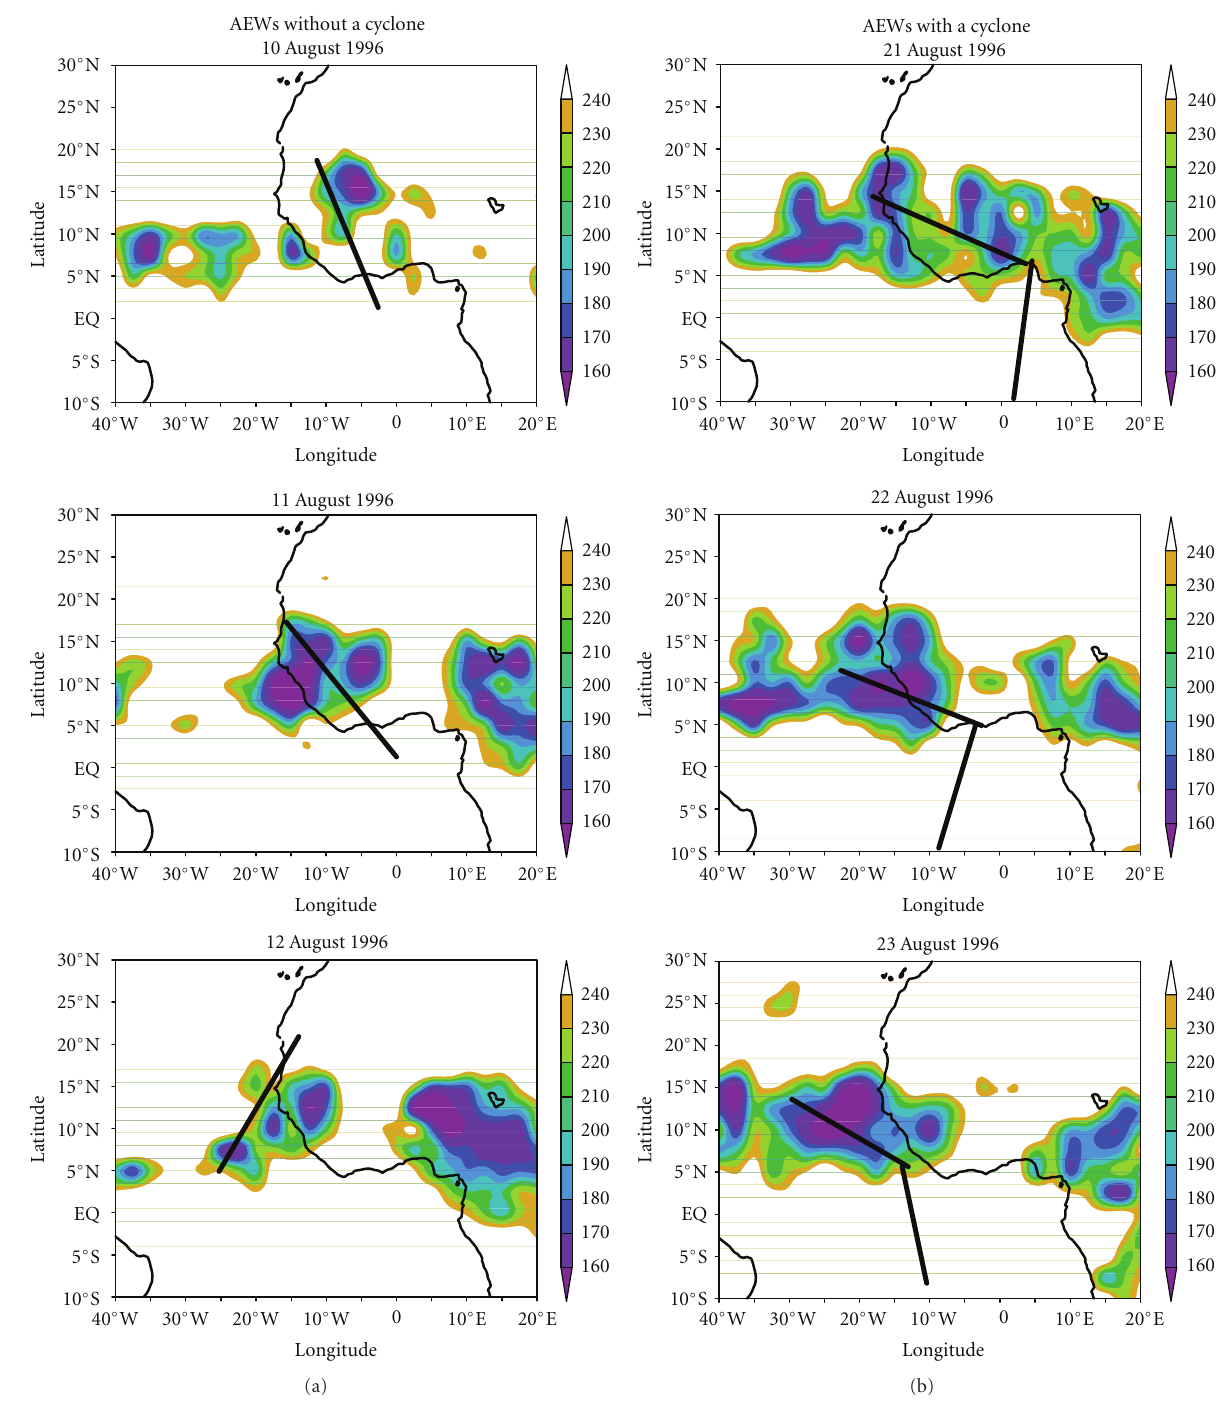
Figure 10: Outgoing Longwave radiation (OLR) for (a) the non-developing AEW (10–13 August 1996) and for (b) the AEW associated with a cyclone (20–23 August 1996). The line represents the location of the trough.